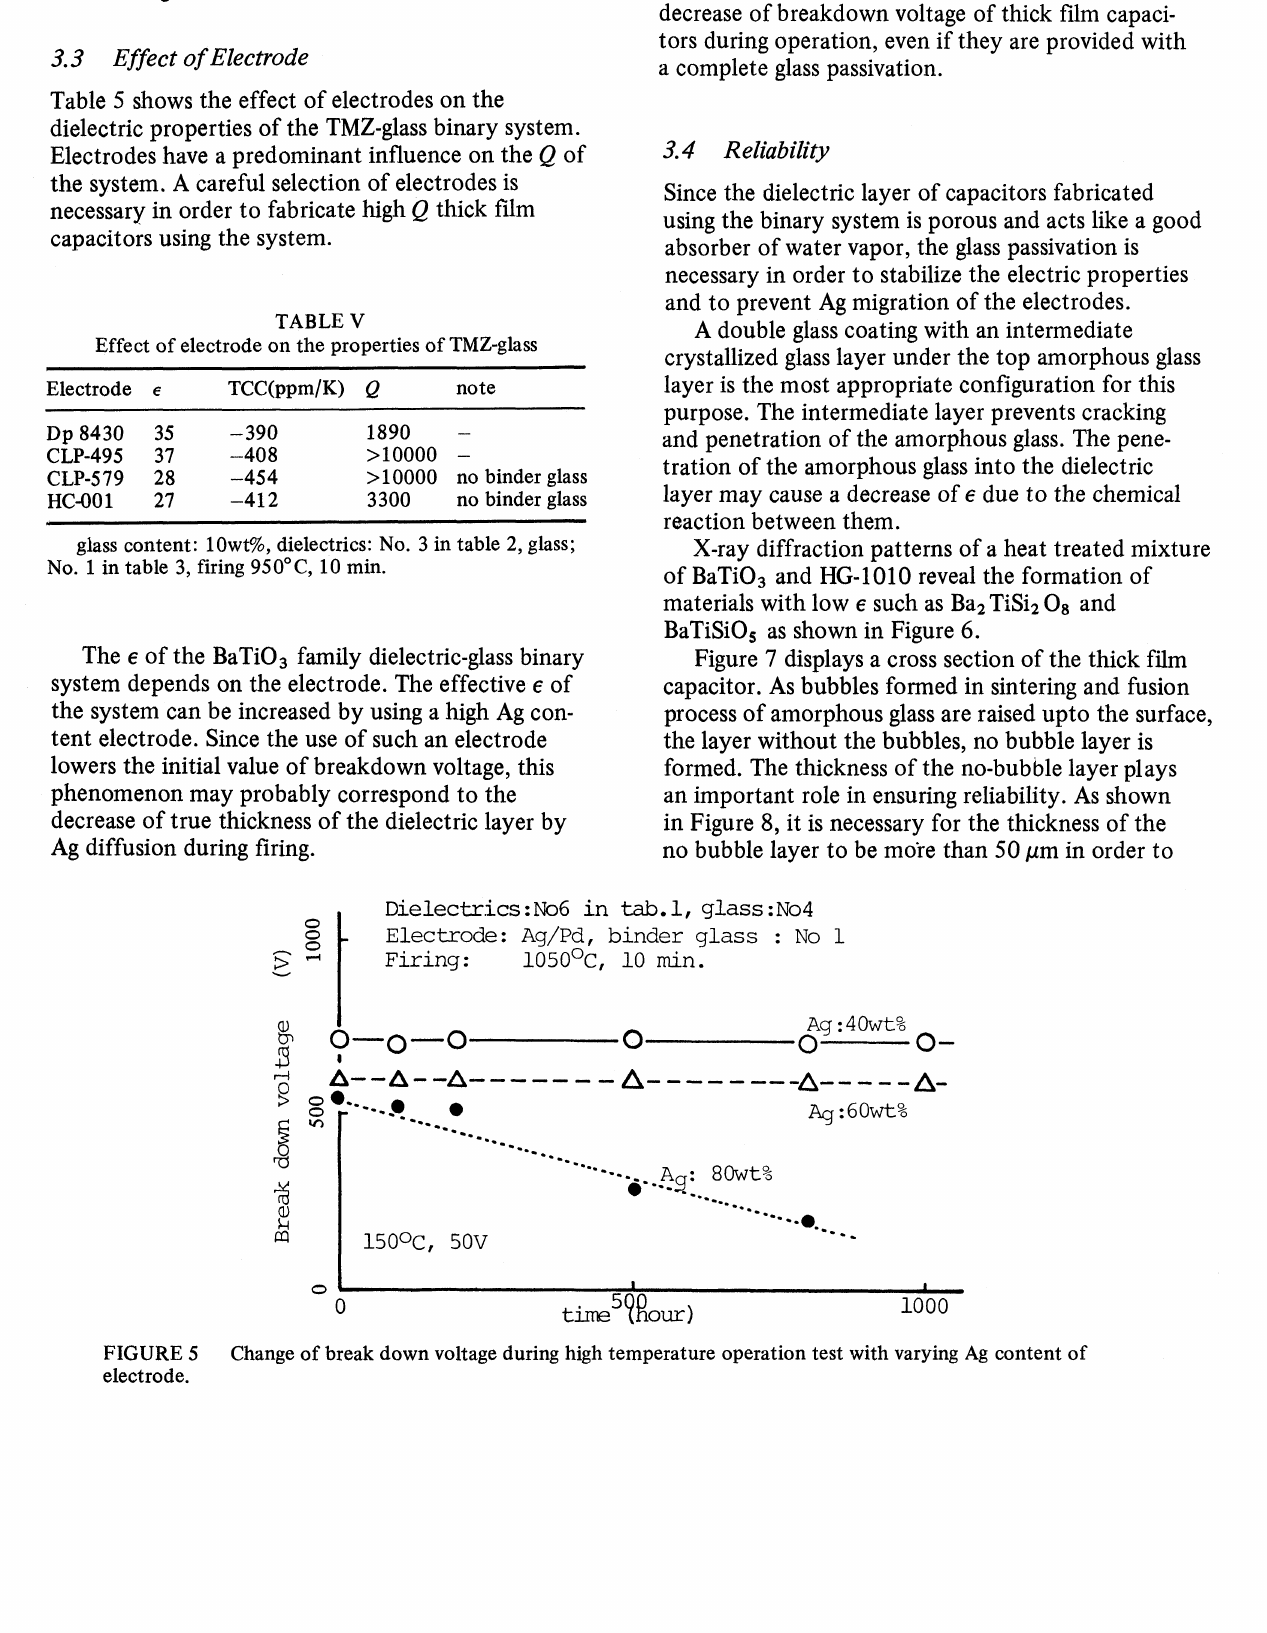
TABLE V Effect of electrode on the properties of TMZ-glass